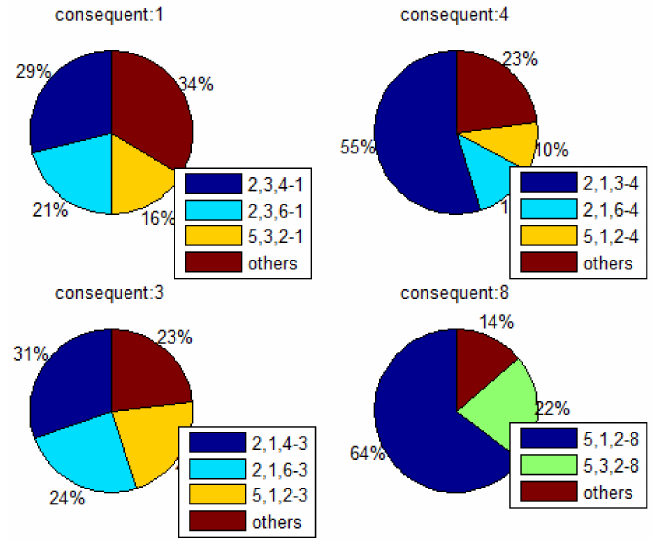
Figure 10. The quantity of the antecedent fixed as